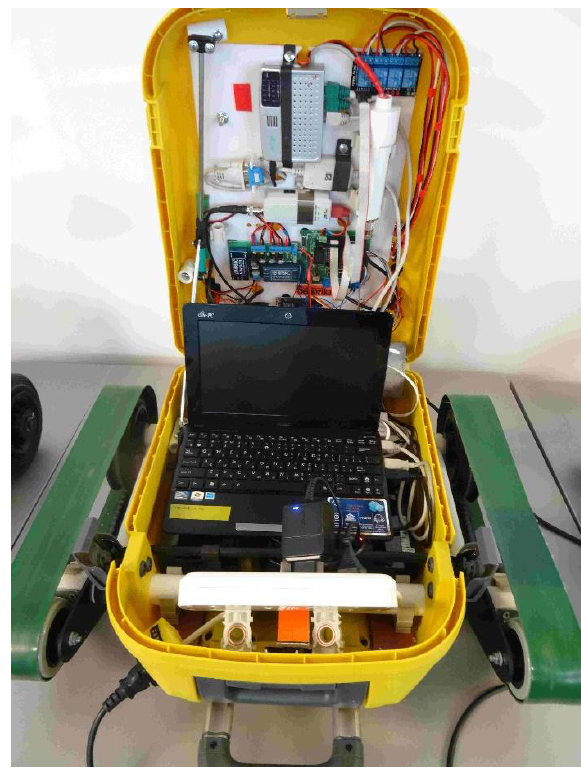
Figure 3. Contents of mobile